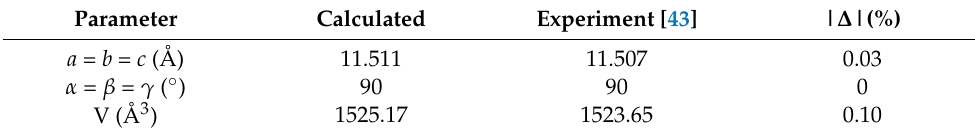
Figure 1. The crystal structure of the almandine garnet. Table 2. Calculated and experimental lattice parameters of almandine